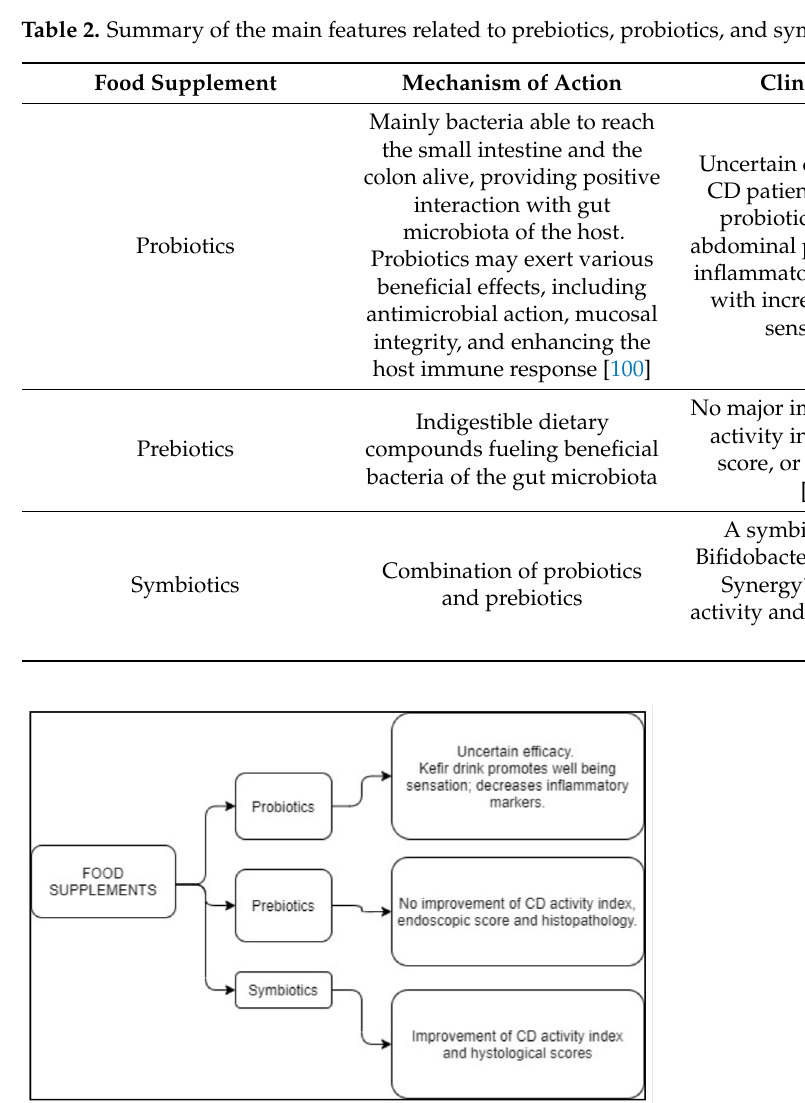
Figure 2. Suggested food supplements for the treatment of